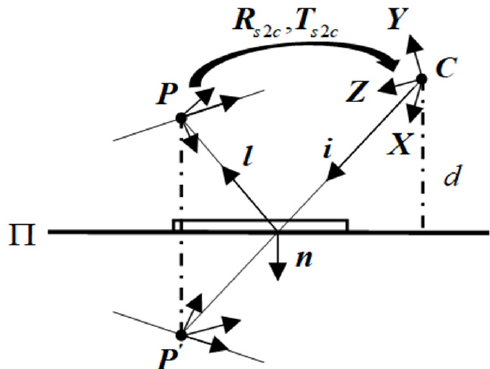
plane coordinate system and the camera coordinate system. P is a feature point on the reference plane.